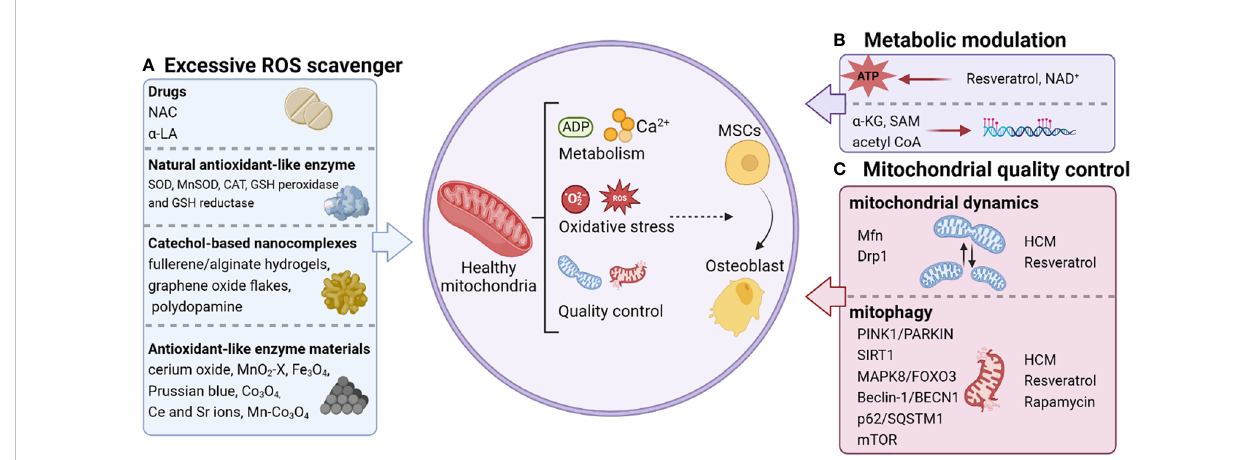
FIGURE 1 Personalized strategies for remodeling mitochondrial homeostasis. The regulation of mitochondrial function that triggers osteogenic differentiation of stem cells includes scavenging excessive ROS (A) , metabolic modulation (B) , and mitochondrial quality control (C) . NAC, N-acetylcysteine; a -LA, alpha-lipoic acid; SOD, superoxide dismutase; CAT, catalase; GSH, glutathione; MnSOD, manganese superoxide dismutase; Ce, cerium; Sr, strontium; NAD + , Nicotinamide adenine dinucleotide; a -KG, alpha-ketoglutarate; SAM, S-adenosylmethionine; acetyl CoA, acetyl coenzyme A; Mfn, Mitochondrial fusion protein; HCM, high molecular weight polyacrylic acid (HPAA)-crosslinked collagen